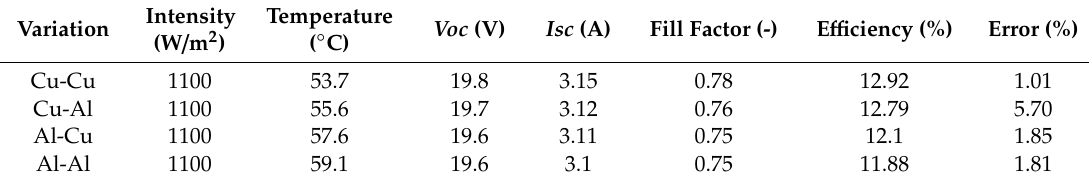
Table 4. Temperature and e ffi ciency of the solar cell with a 10-fin heat sink.